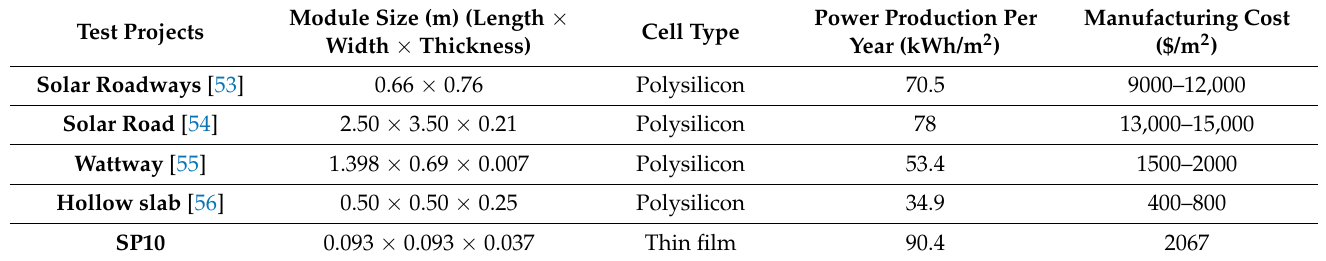
Table 9. Energy production and cost comparison of other test projects on solar pavements